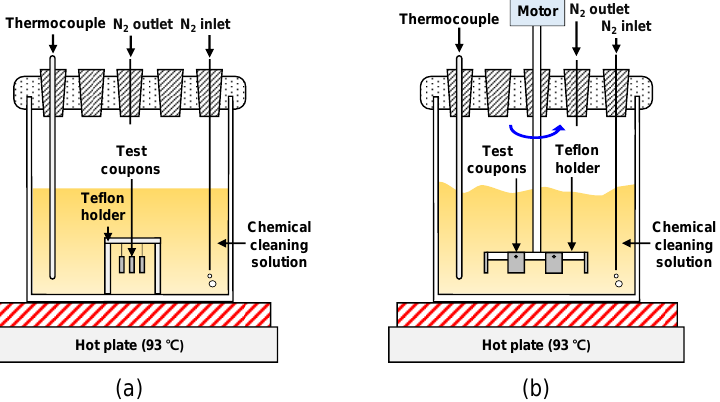
Figure 5. Schematic diagrams of the corrosion test apparatus under ( a ) the stagnant condition; ( b ) the flowing condition.